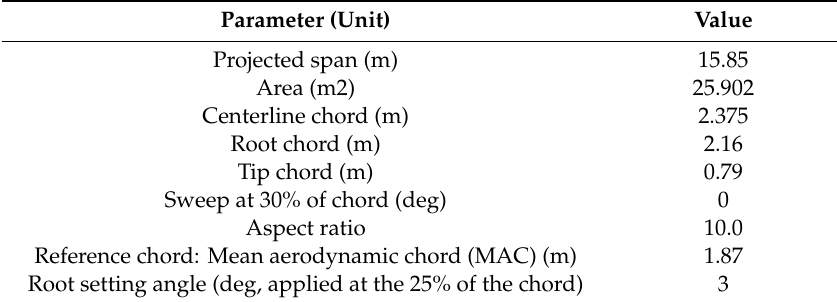
Table 3. Geometrical reference data for the wing (geometry information from [25,26]).